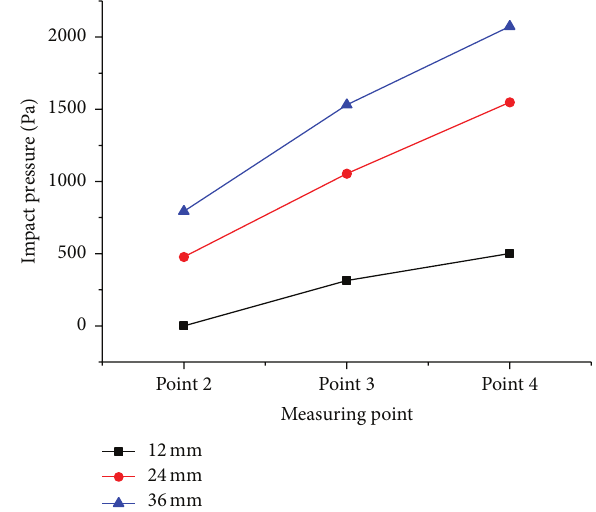
Figure 6: The distribution of impact pressure of case 1 with 24 mm